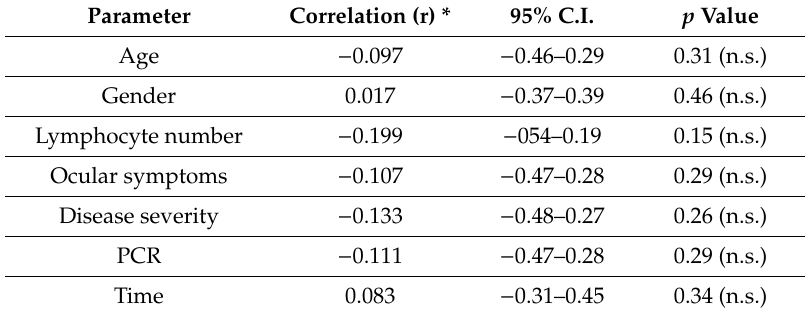
Table 2. Correlation between clinical parameters and ocular IgA detection in recruited COVID-19 patients. Parameter Correlation (r) * 95% C.I. p Value Age − 0.097 − 0.46–0.29 0.31 (n.s.) Gender